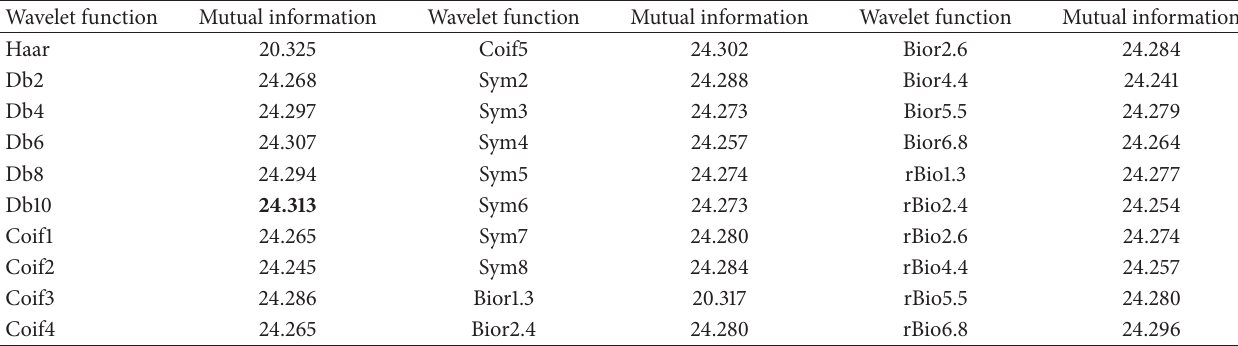
Table 1: Mutual information resulted from the simulation signal for different wavelets. Wavelet